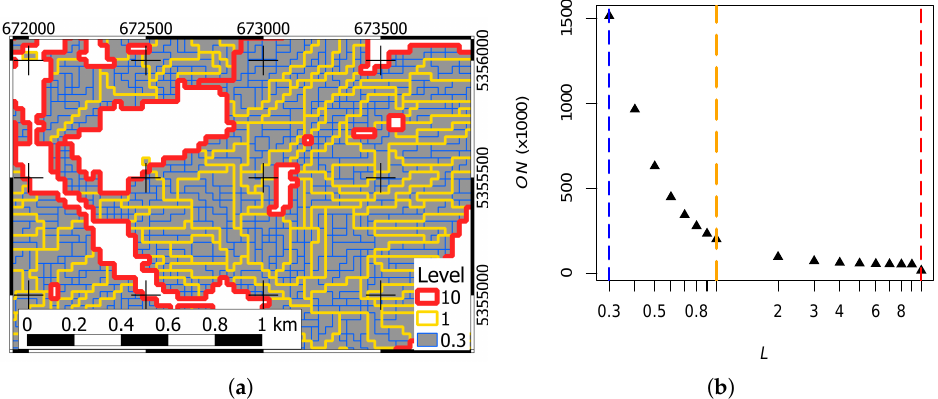
Figure 5. Visualization of reference unit-specific scale levels on the example of a test site subset ( a ) as well as relation between logarithmized scale level L and object number ON (( b ); cf., Table 3). The colored dashed lines refer to the scale levels L = 0.3, L = 1 and L = 10. ( a ) White areas represent land that is not used by